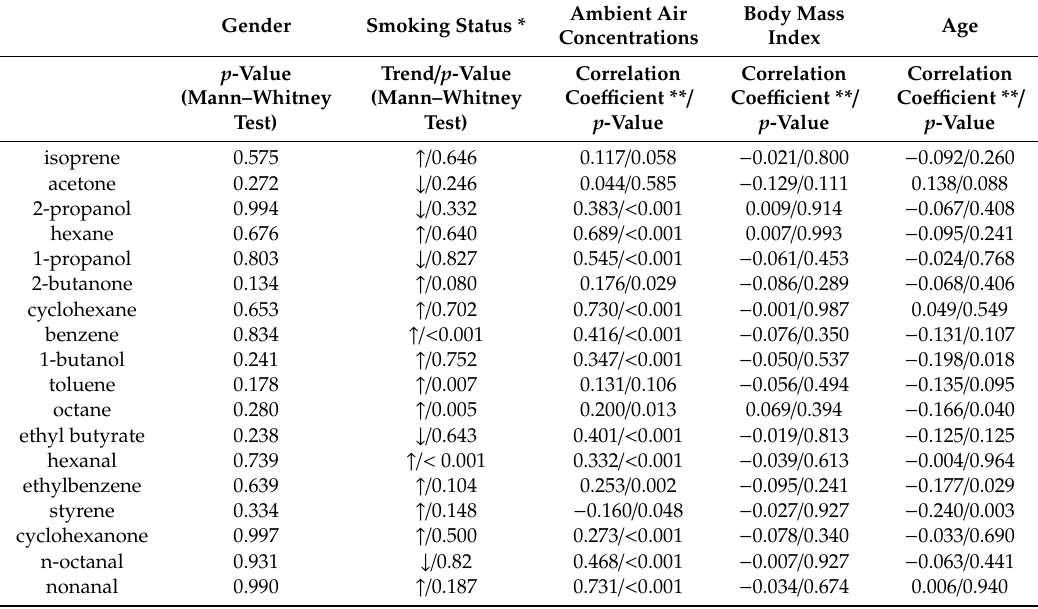
Table 2. Determinants of volatile organic compounds (VOC) breath concentrations.